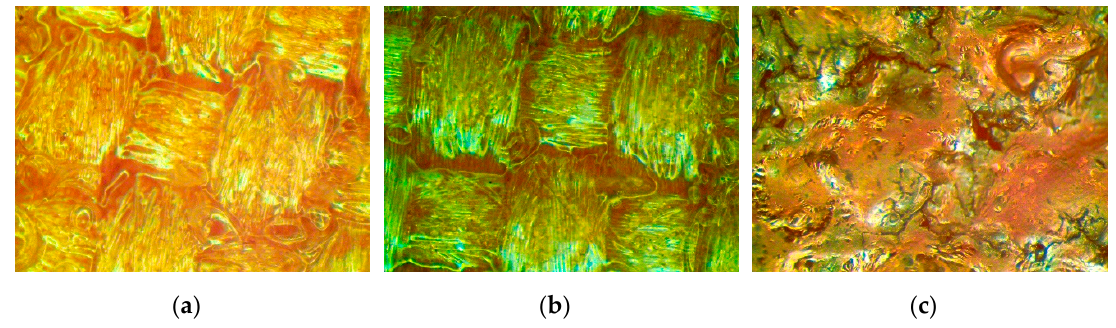
Figure 9. Microscopic images of the surface of the Cordura composite substrate. ( a ) Without modification; ( b ) After laser modification, 4 W beam power; and ( c ) After laser modification, 6 W beam power.